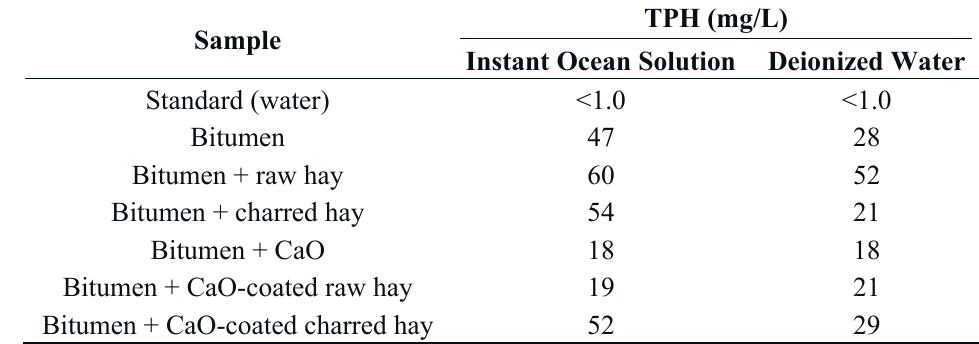
Table 2. Total Petroleum Hydrocarbons (TPH) in water samples collected from water column after